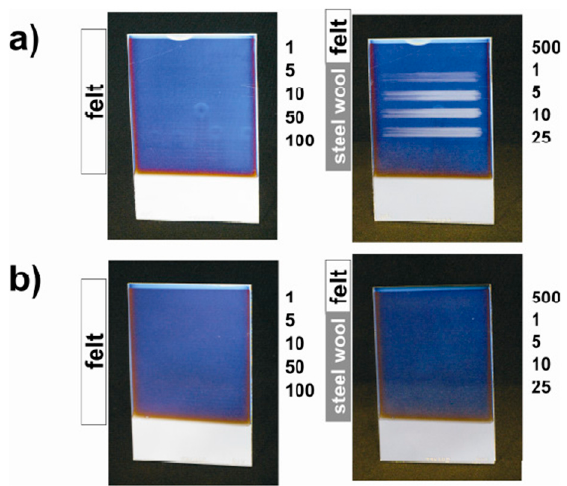
Figure 4. Photographs of MgF 2 thin films on ( a ) soda-lime and ( b ) borosilicate glass substrates that had undergone the Crockmeter test with felt and steel wool. The numbers at the right side of the images correspond to the respective number of abrasion cycles. All samples have been treated at 500 °C prior to analysis. Reproduced from Reference [36] with the permission of the Royal Chemical Society.